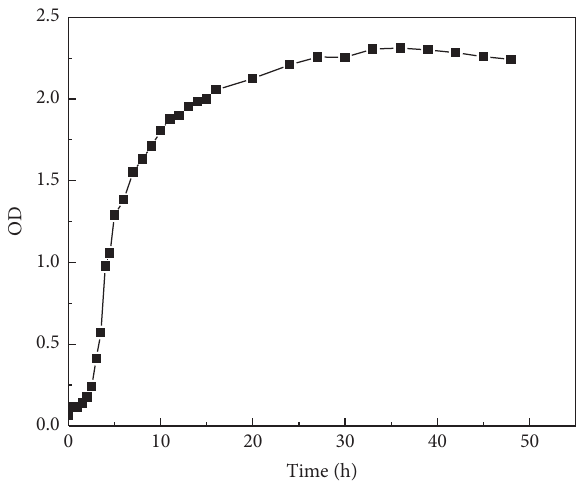
Figure 2: Variations in bacterial concentration with time. Figure 3: Variations in bacterial urease activity with